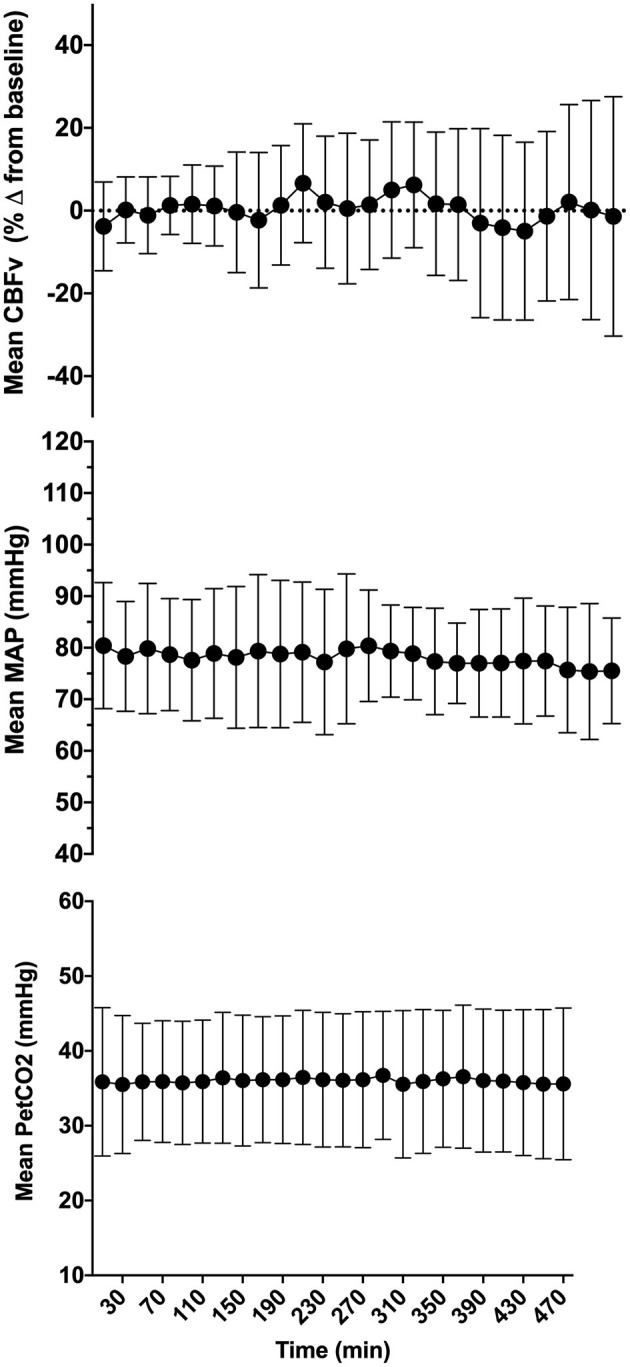
Mean cerebral blood flow velocity (CBFv), mean arterial pressure (MAP), and end-tidal PCO2 (PetCO2) across all patients included in the final analysis. Error bars represent standard deviation. CBFv was expressed as percent change from baseline to enable comparison across patients.